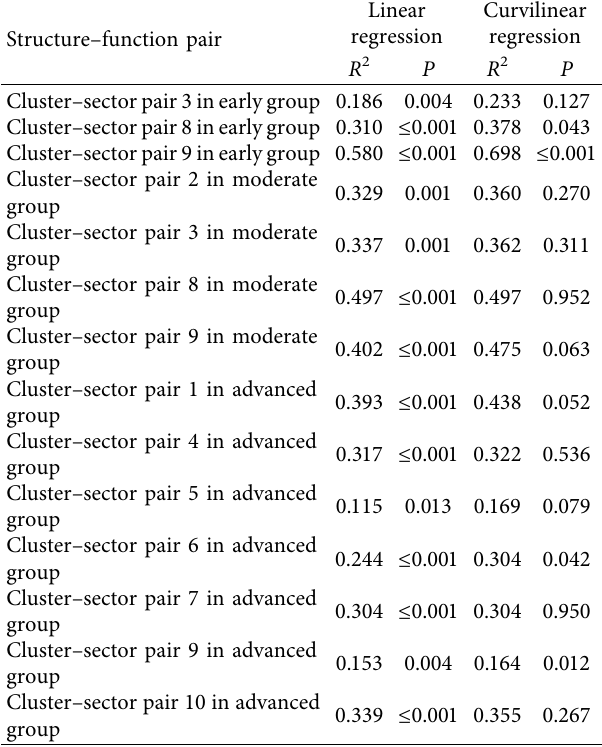
Table 3: The regression results of the cluster–sector pairs with significant correlation in each subgroup ( P < 0 . 01). Structure–function